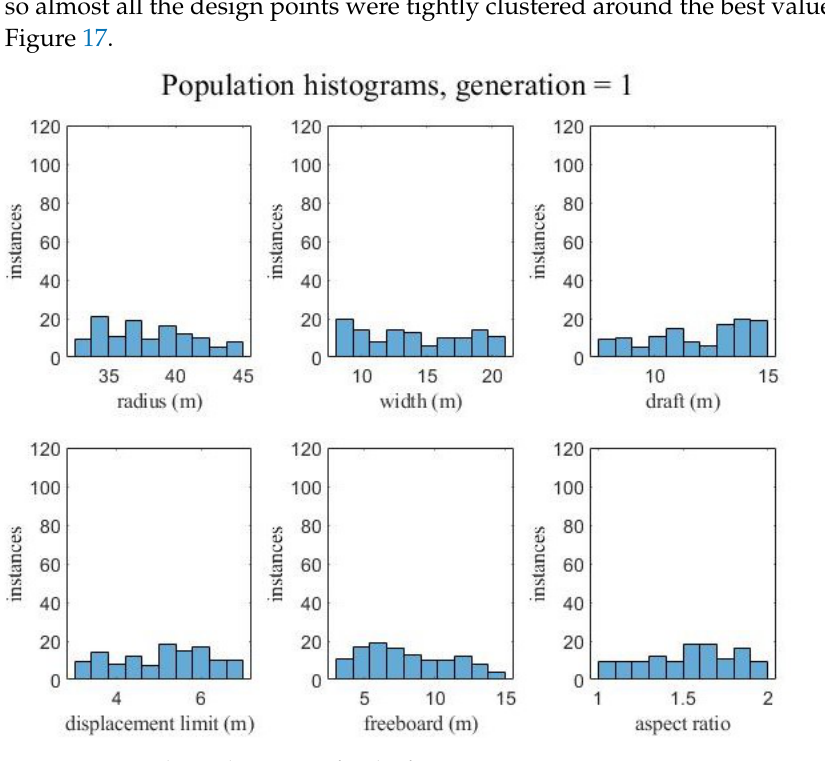
Figure 15. Population histogram for the first